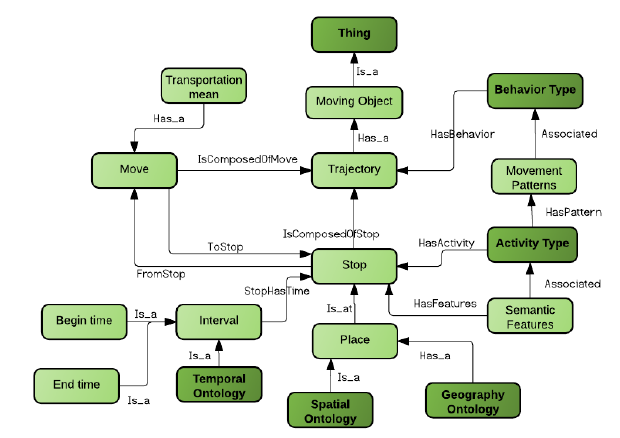
Figure 3. Semantic trajectory ontology